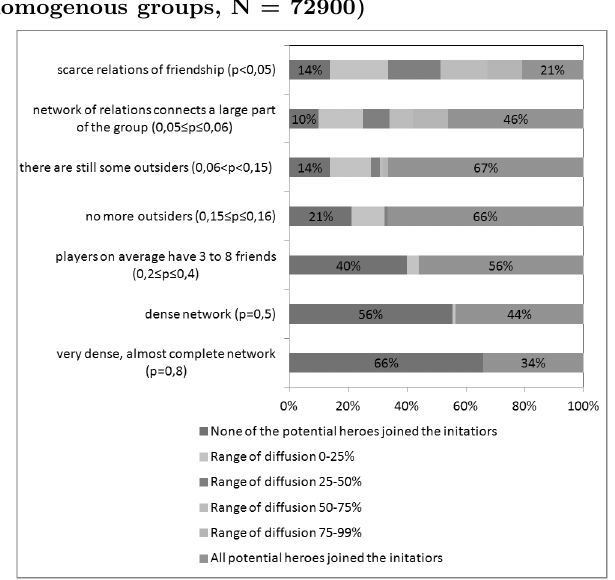
Graph 5. Range of diffusion depending on network characteristics (homogenous groups, N =